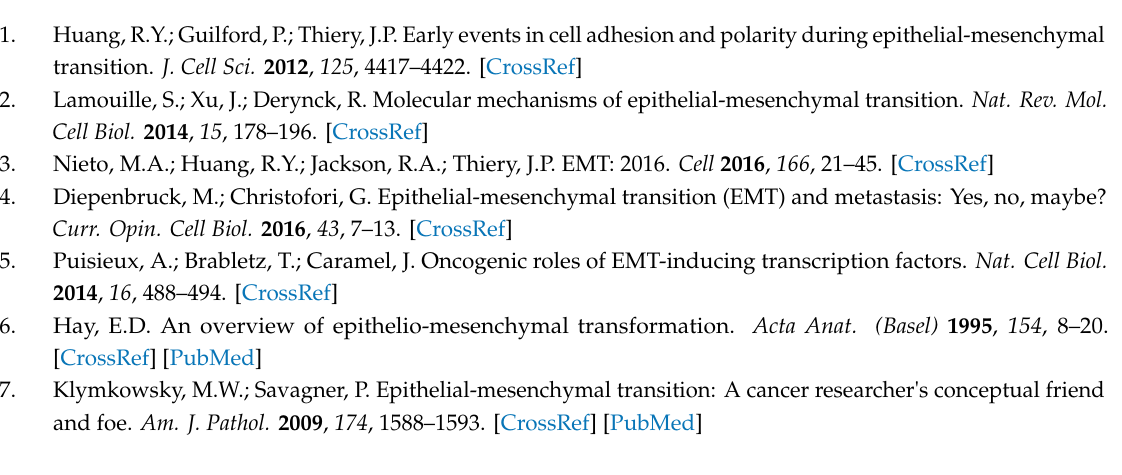
Figure S1: Immunostaining of p34 and E-cadherin in control and EGF-treated IAR-20 cells. Figure S2: Control IAR-20 cells expressing GFP-E-cadherin form a continuous monolayer at the beginning of the experiment. Figure S3: Immunofluorescent staining for β -catenin / actin / EPLIN in IAR-20 cells treated with EGF for 15 and 30 min. Figure S4: Western blot analysis of EPLIN. Video S1: Scattering of IAR-20 epithelial cells in response to EGF. Video S2: Disappearance of contact paralysis in the culture of IAR-20 epithelial cells in the presence of EGF. Video S3: Disruption of the circumferential actin bundle and appearance of pseudopodia at the cell-cell-boundaries after the addition of EGF. IAR-20 cells stably expressing F-tractin-tdTomato. Video S4: Myosin retrograde flow in IAR-20 cells treated with EGF. IAR-20 cells stably expressing GFP-RLC. Video S5: Displacement of ConA-coated beads attached to the dorsal cell surface in the zone of cell-cell contact before and after the addition of EGF. Video S6: Rearrangement of E-cadherin-based AJs in IAR-20 cells treated with EGF. IAR-20 cells stably expressing GFP-E-cadherin. Video S7: Rearrangement of E-cadherin-based AJs in IAR-20 cells treated with EGF. Enlarged region of Supplementary Video S6. Video S8: Accumulation of zyxin in AJs of IAR-20 cells treated with EGF. IAR-20 cells stably expressing GFP-E-cadherin were transfected with